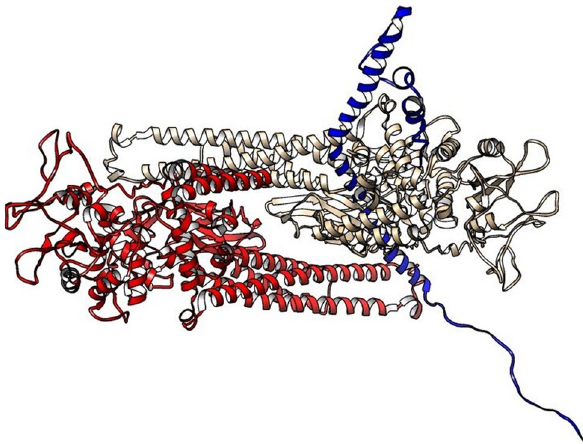
Figure 6. STAT3 dimers (monomers in gold and red colors) in complex with one molecule of GRIM-19 (in blue